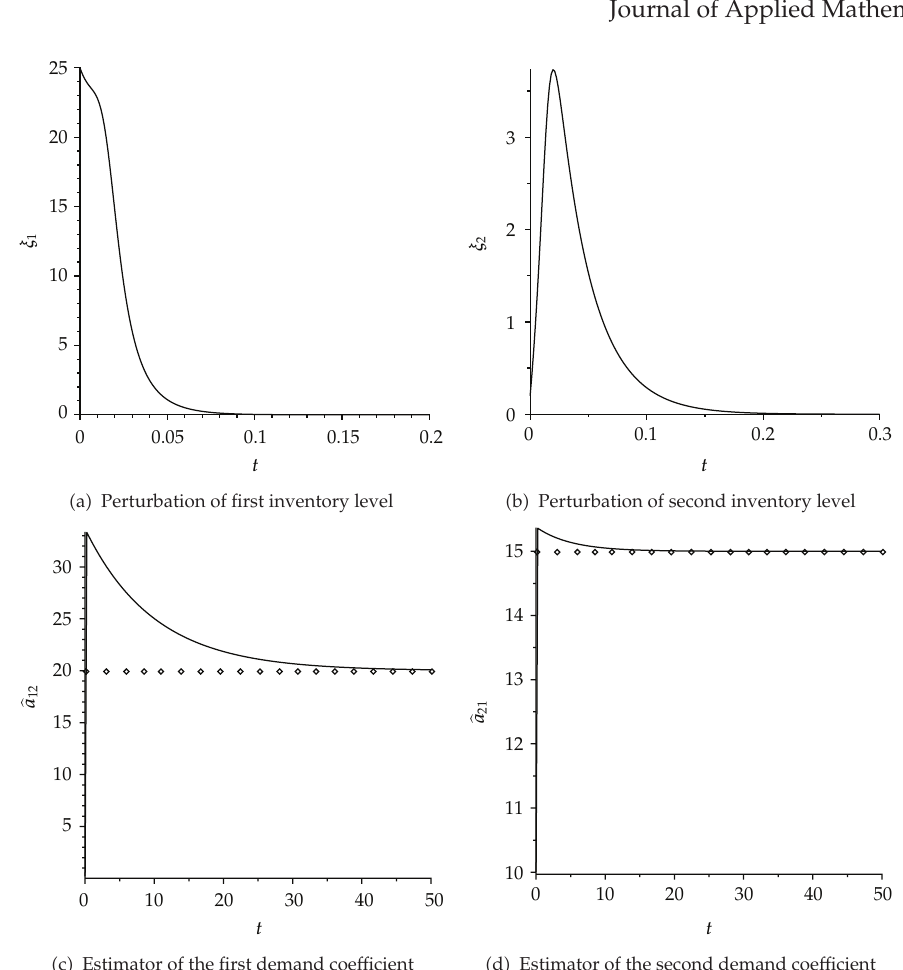
Figure 5: (cid:6) a (cid:7) and (cid:6) b (cid:7) are the perturbation of the first and second inventory levels about their inventory goal levels as the demand rate is an exponential function of the time. (cid:6) c (cid:7) and (cid:6) d (cid:7) are the di ff erence between dynamic estimators of the first and second demand rates and their real